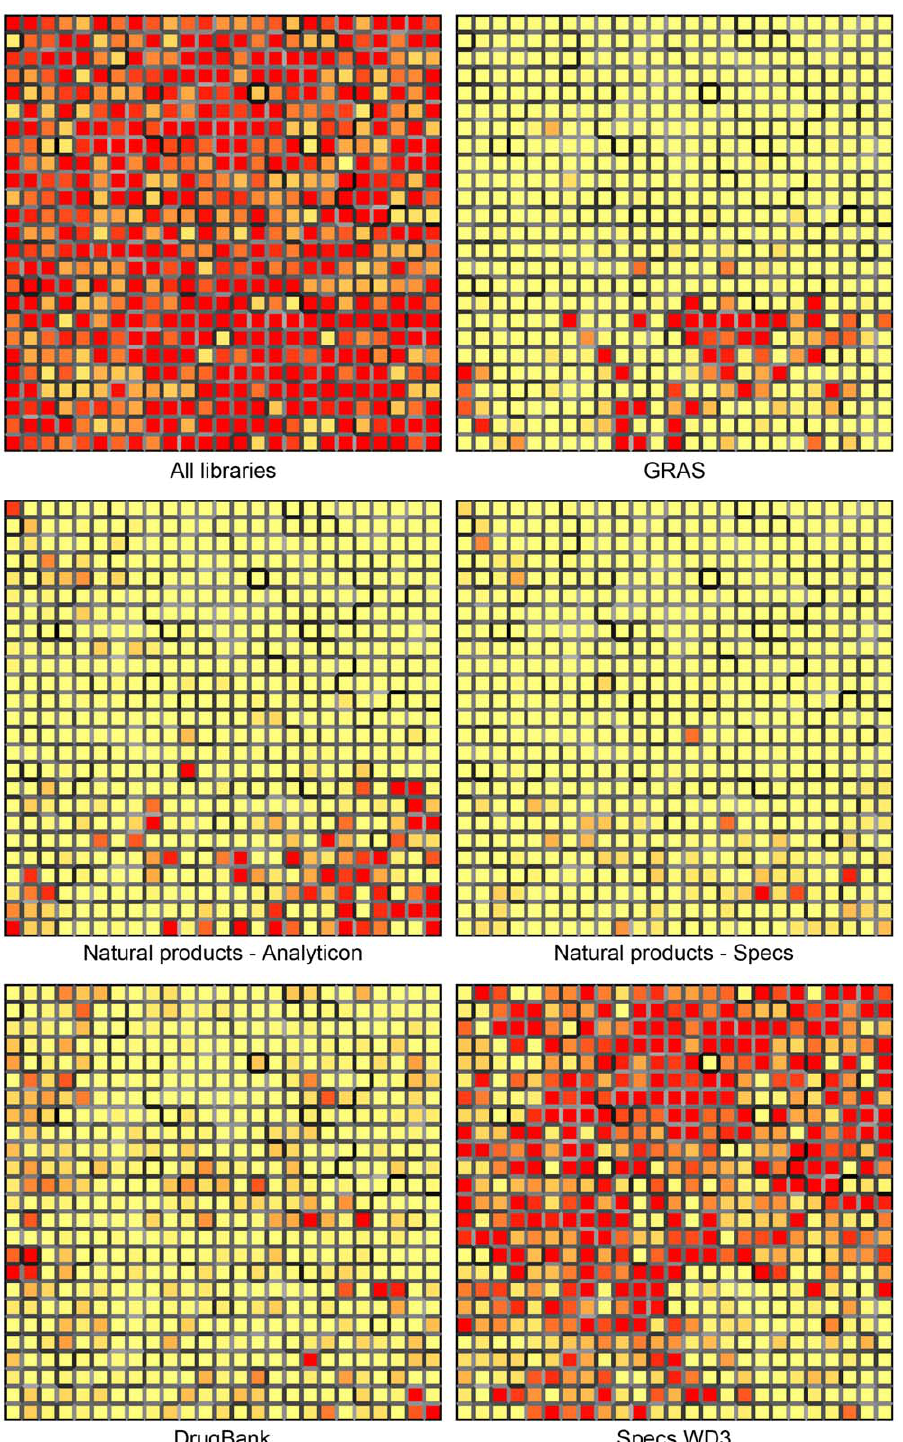
Figure 5. 25 6 25 Self-Organizing-Maps for all five libraries and each library independently. Cells are colored by population, with light yellow for empty cells, and red for cells containing 24 or more compounds. The shading of cell borders indicates the distance between adjacent cells; darker borders indicate larger distance. doi:10.1371/journal.pone.0050798.g005 measure intra-library similarity. For each compound in DrugBank Comparison of chemical structures with approved drugs. The molecular databases were also compared to drugs the maximum MACCS keys and radial similarity were determined using the same MACCS keys and radial fingerprints employed to and compared to all molecules in the test database using the